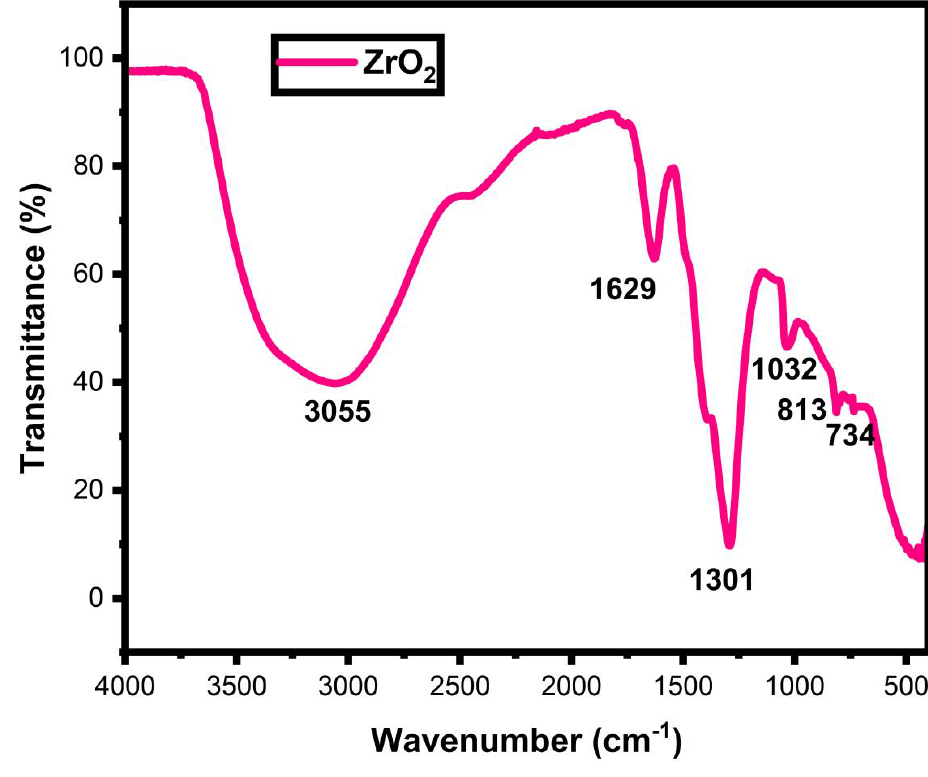
Figure 2. FTIR spectrum of biosynthesized ZrO 2 NPs.